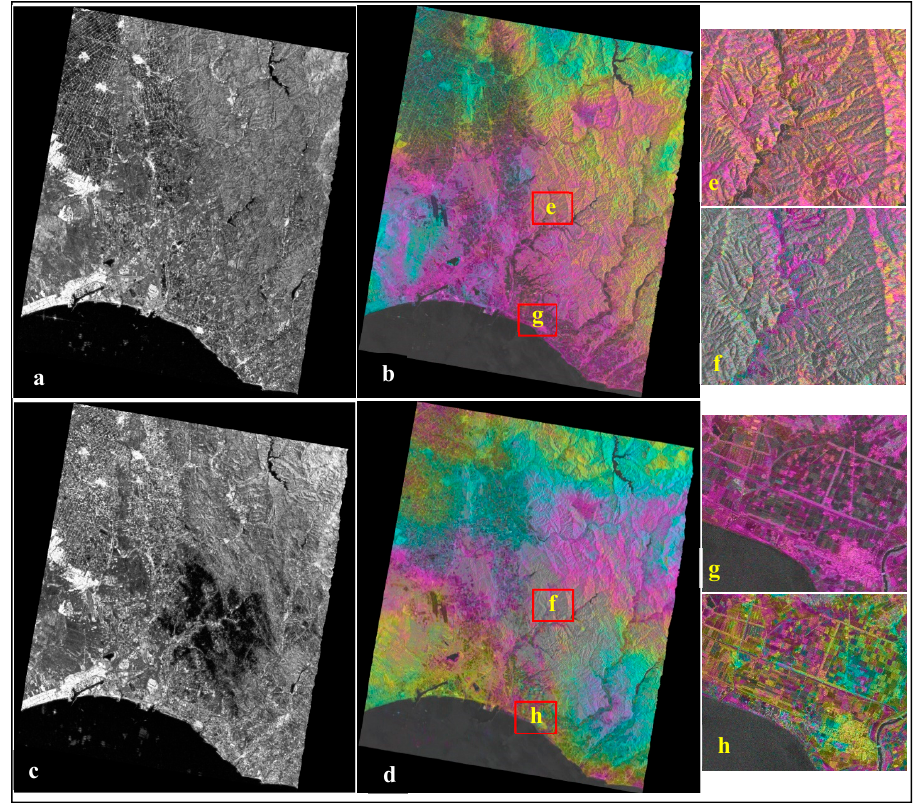
Figure 5. PALSAR-2 interferogram from pre-and co-event image pairs (descending). ( a ) and ( b ) are the coherence and interferogram of pre-event image pair (20180823-20180614); ( c ) and ( d ) are the coherence and interferogram of co-event image pair (20180823-20180906); ( e – h ) are the enlarged views of the pre- and co-event